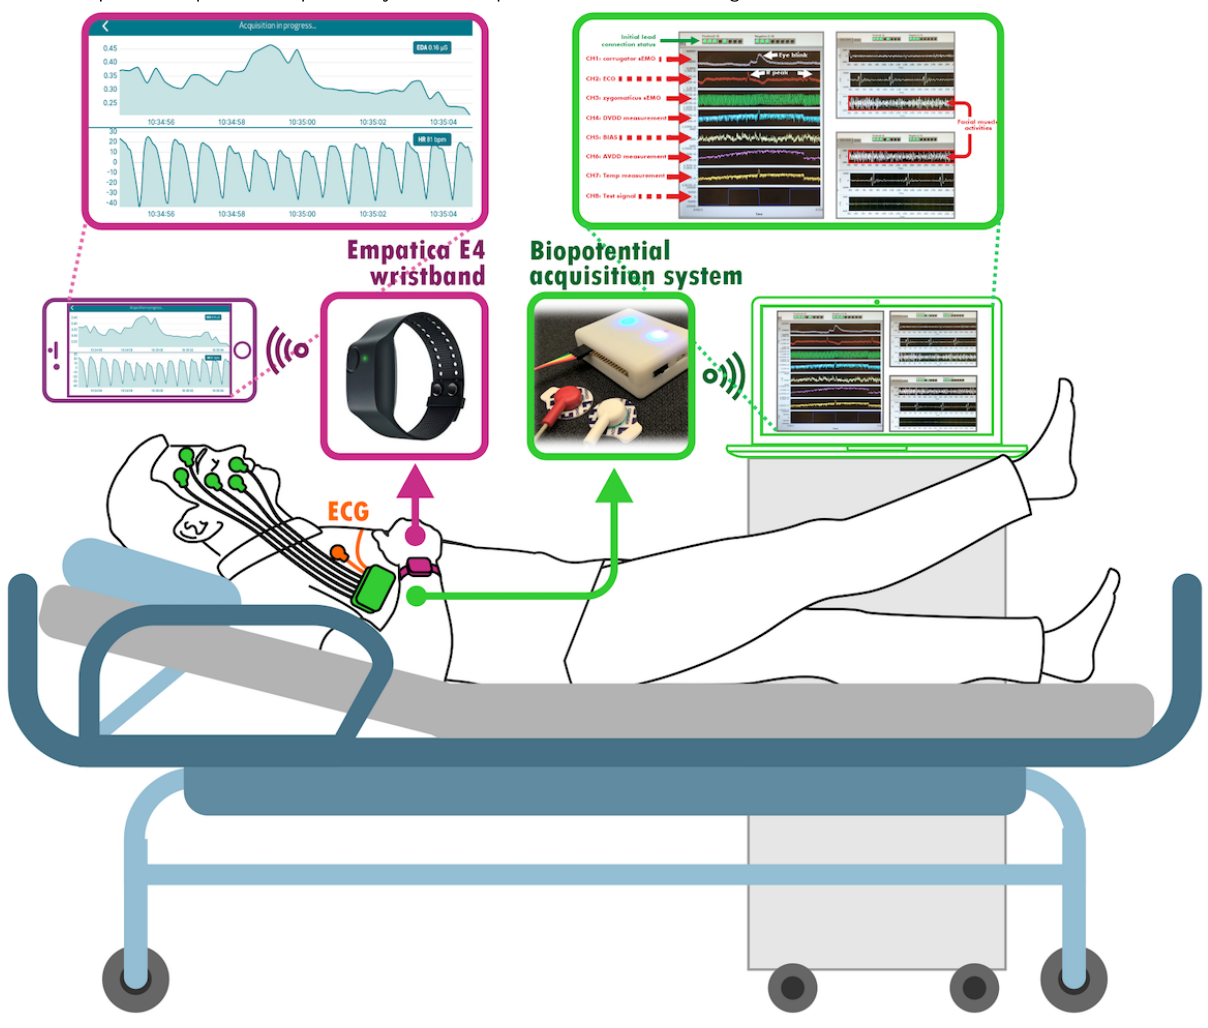
Figure 2. Setup of the biopotential acquisition system on the patient. ECG: